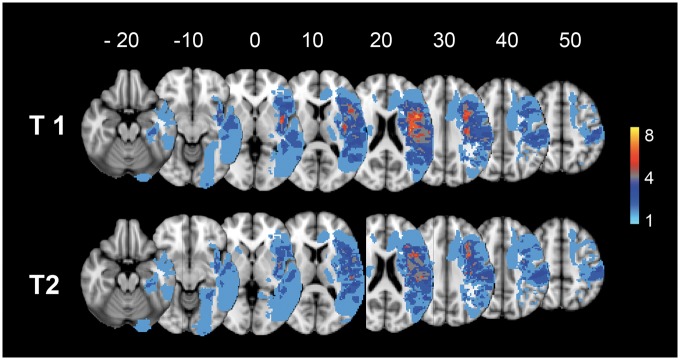

Overlay of the lesion distribution in the patients with left hemisphere stroke, projected on standard brain templates. Lesions were defined separately at each time point. The colour code represents the number of patients with a lesion in a given voxel. The numbers above the brain slices represent the MNI coordinates in the z plane, in millimetres. T1: ∼2 weeks after stroke; T2: ∼4 months after stroke. Lesion volumes were highly correlated across both sessions (r = 0.969, P < 0.001) but they were lower in the second session reflecting post-stroke atrophy of the surrounding tissues. The values derived from the first session were used in the analyses and are listed in Supplementary Table 1.